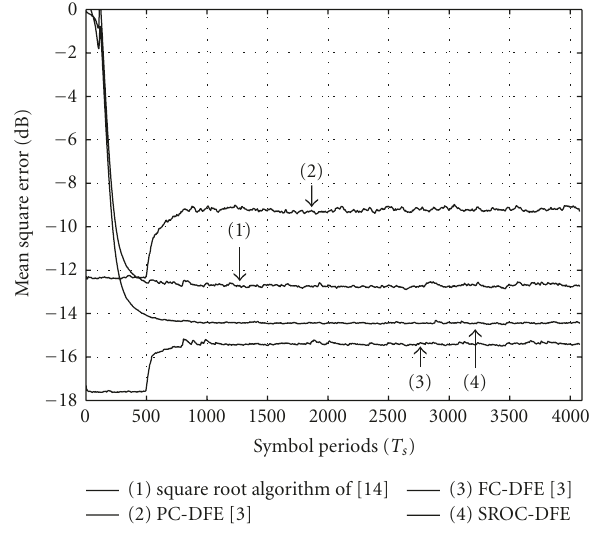
Figure 3: Convergence and steady-state performance of equalizers for a 4 × 4 system trained for 512 T s , and operating over a static frequency-selective MIMO channel at SNR =